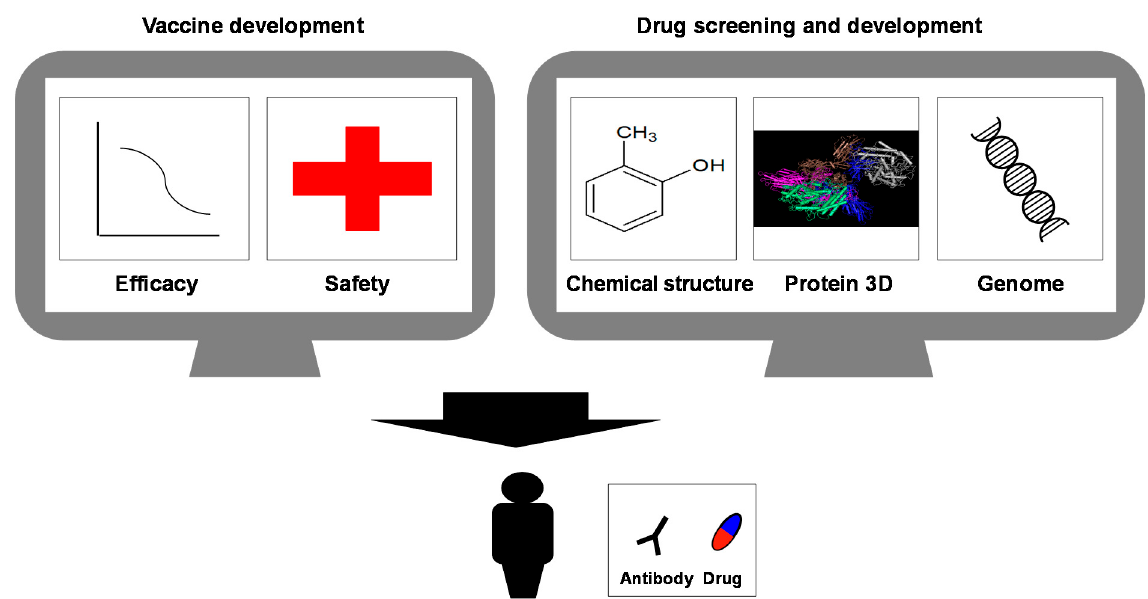
Figure 2. AI and COVID-19 therapeutics. Computational analysis is used for both vaccine development and chemical drug development. Prediction of vaccine efficacy, half-life, and safety can be analyzed in vaccine development. For drug development, publicly available or crowdsourced datasets are used to accelerate target screening and candidate compound design.